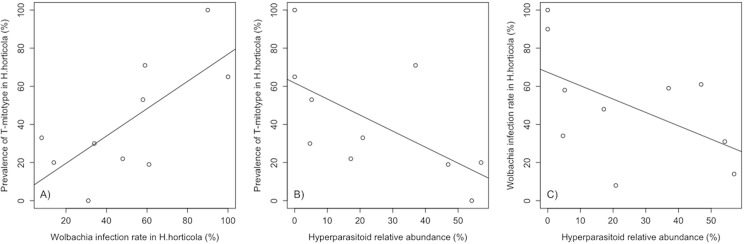
Relationships between Hyposoter horticola mitotype, Wolbachia infection and hyperparasitism by Mesochorus c.f. stigmaticus in 10 sub-regions in the Åland islands.The data were collected from 2008 to 2013. Panel (A) shows the association between Wolbachia infection rate and the relative abundance of the T mitotype in H. horticola (P = 0.01). The next two panels show the relationships between the relative abundance of the hyperparasitoid and (B) the relative abundance of the T mitotype (P = 0.039) and (C) Wolbachia infection rate (P = 0.11).